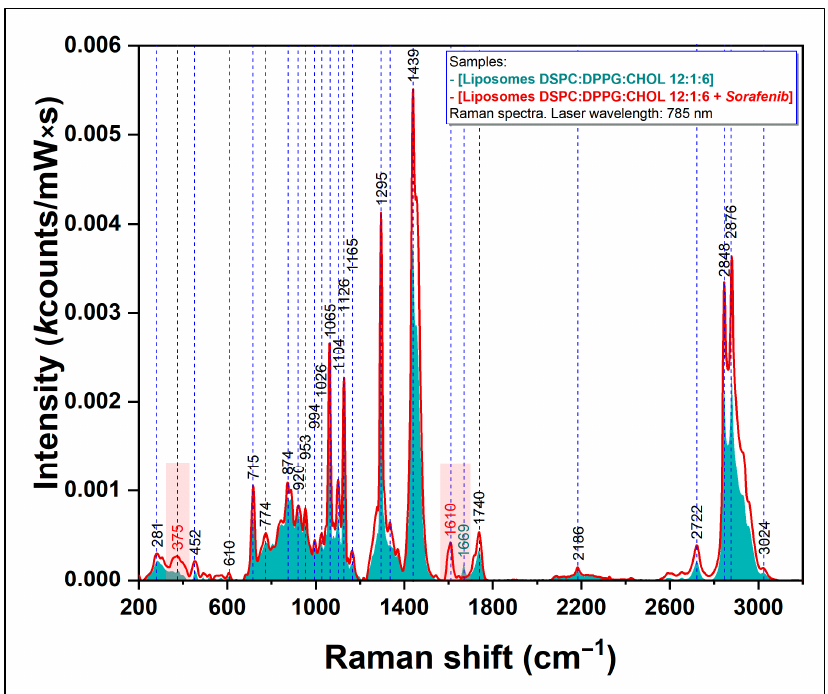
Figure 2. Raman spectra of pure (blue line) and sorafenib-loaded nanoliposomes (red curve) (the laser wavelength is 785 nm).